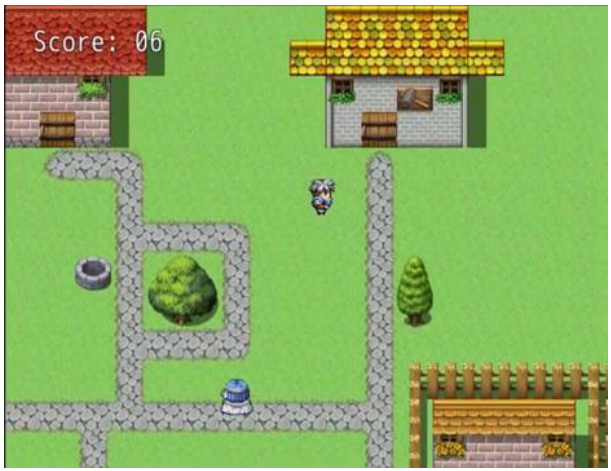
Figure 6. The village is a location for exploration. The VC meets the girl and then finds the blacksmith’s shop.